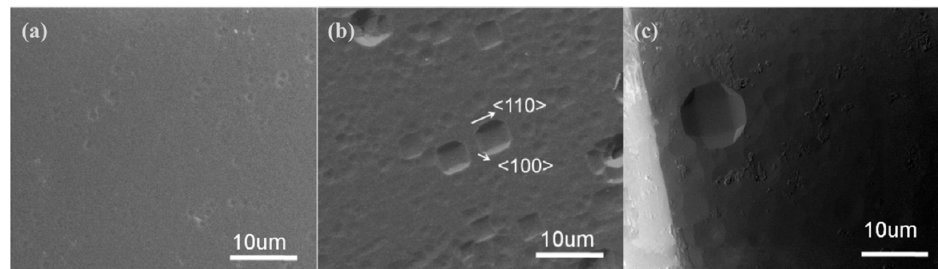
Figure 4. Morphology of the diamond {100} face after etching at 600 °C for different times: ( a ) 30 min; ( b ) 1 h; and ( c ) 1.5 h [87]. Reproduced with permission from Elsevier.